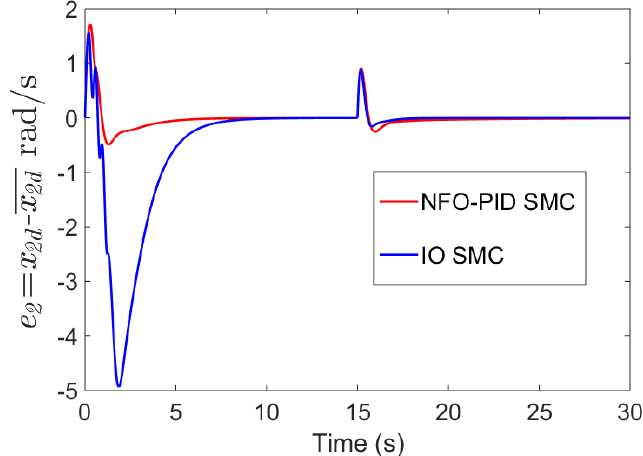
Figure 3. Curves of error e 2 . Appl. Sci. 2020 , 10 , x FOR PEER REVIEW Table 3. Performances of the controllers.